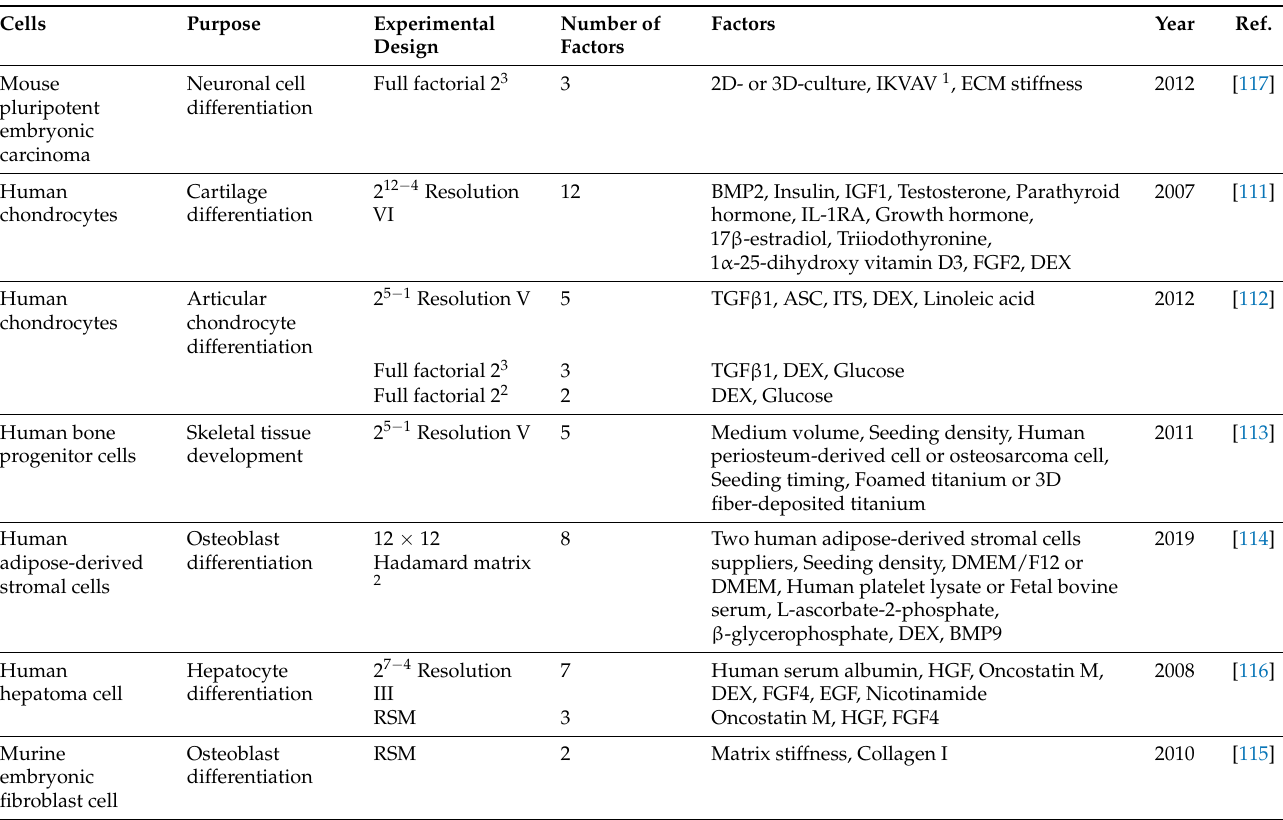
Table 7. DOE studies investigating other cell